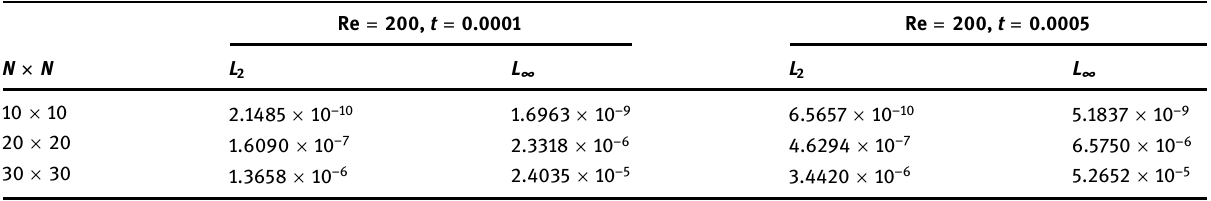
Table 11: Error norms for di ff erent Reynolds number